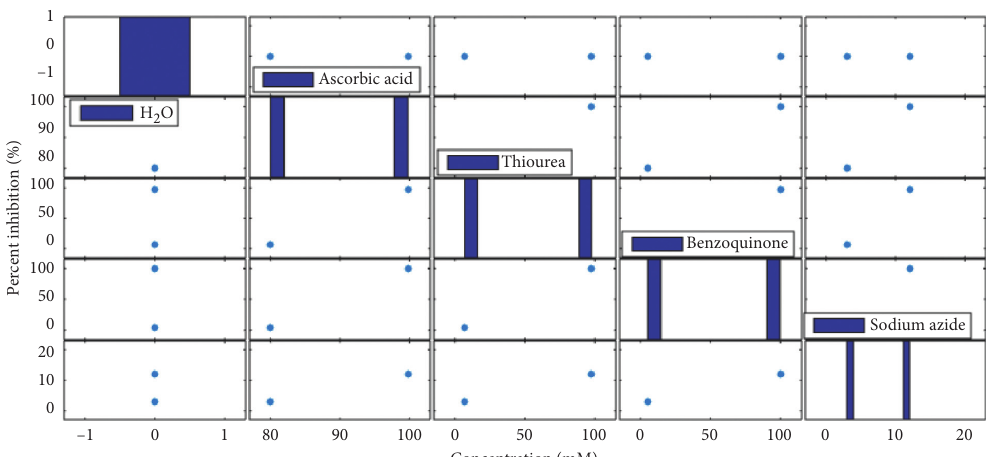
Figure 4: Effect of different free-radical scavengers on CL of the luminol-h